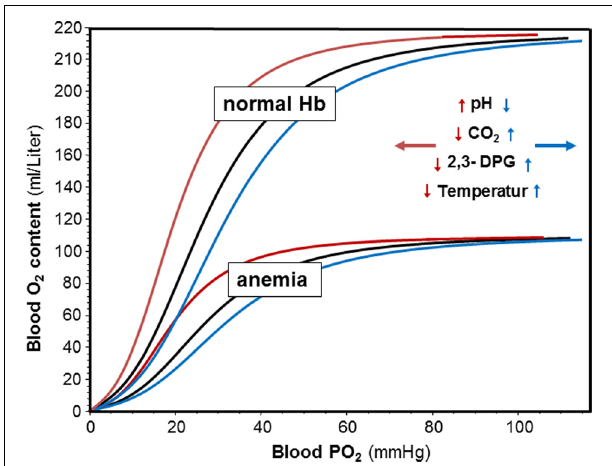
FIGURE 1 | Effects of hemoglobin concentration and pH, CO 2 , 2,3-DPG and temperature on blood oxygen content and on Hb-O 2 affinity. Oxygen dissociation curves (ODC) were calculated with the equation by Severinghaus (1979) using decreased, normal, and increased P 50 values. Oxygen content was calculated from SO 2 and normal and decreased hemoglobin concentrations assuming that 1g H binds 1.34ml of O 2 . The insert indicates that an increase in pH, and a decrease in CO 2 , 2,3-DPG and temperature shifts the ODC to the left (red arrows and curves), whereas acidosis and increased CO 2 , 2,3-DPG and temperature shift the ODCs to the